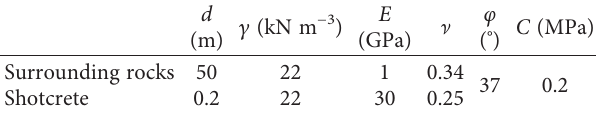
Table 1: Parameters of surrounding rocks and lining